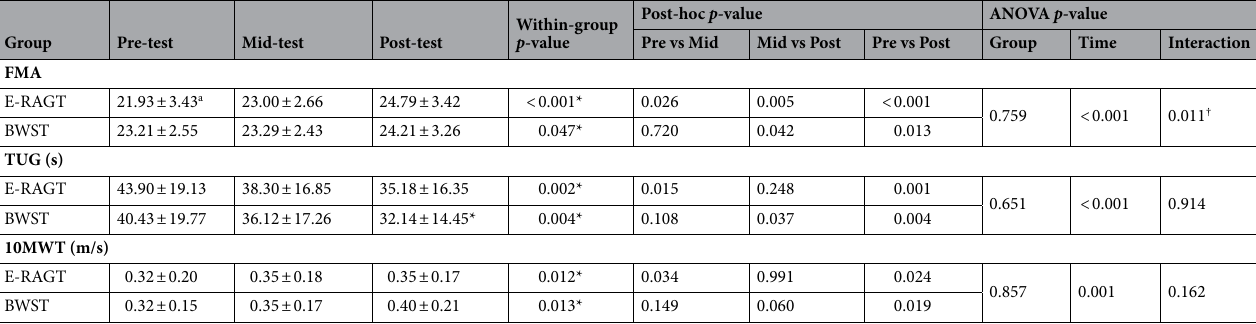
Table 4. Clinical measurements in the E-RAGT and BWST groups. At baseline, there were no significant differences between the E-RAGT and BWST groups for any variable. E-RAGT end-effector robot-assisted gait training, BWST bodyweight-supported treadmill training, FMA Fugl–Meyer assessment, TUG timed up and go test, 10MWT 10-m walk test. *Significant within-group difference, based on repeated-measures analysis of variance (ANOVA), p < 0.05. † Significant Group × Time interaction effect, based on two-way mixed repeated- measures ANOVA with factors of group (E-RAGT and BWST) and times (pre-test, mid-test, and post-test), p < 0.05. a Mean ± standard